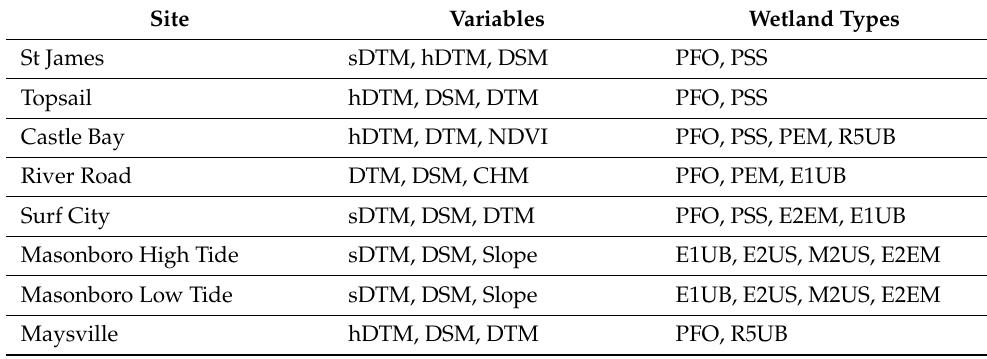
Table 4. List of sites and three most important variables when creating XGBM decision trees based on Leave-One-Site-Out pooled data, ranked from highest to